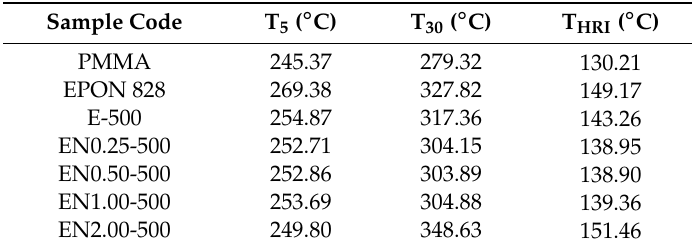
Table 2. Temperature values at 5% and 30% weight loss and heat resistance index of epoxy, PMMA, and PMMA microcapsules containing epoxy/CNT mixtures.